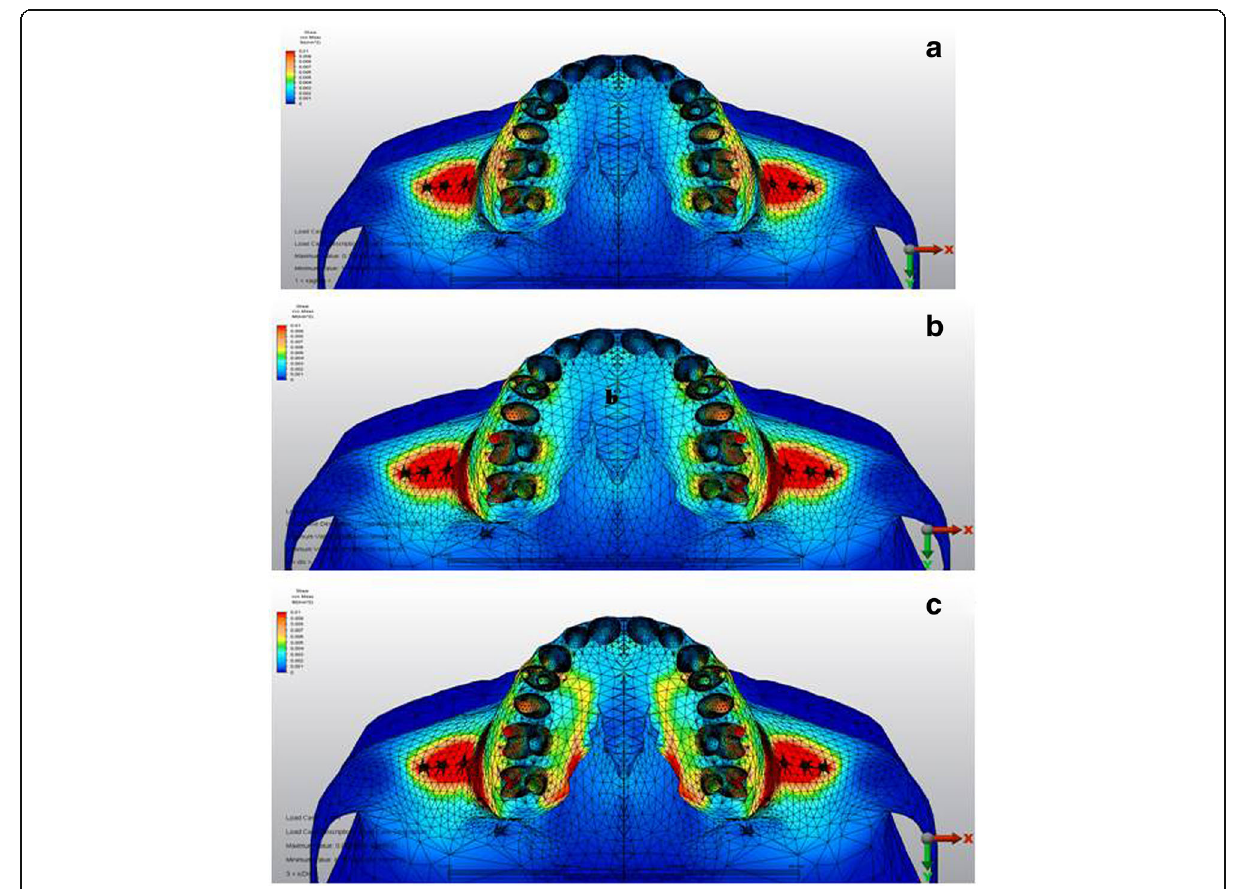
Fig. 6 Stress distributions from occlusal view over cancellous bone a first, b second, and c third